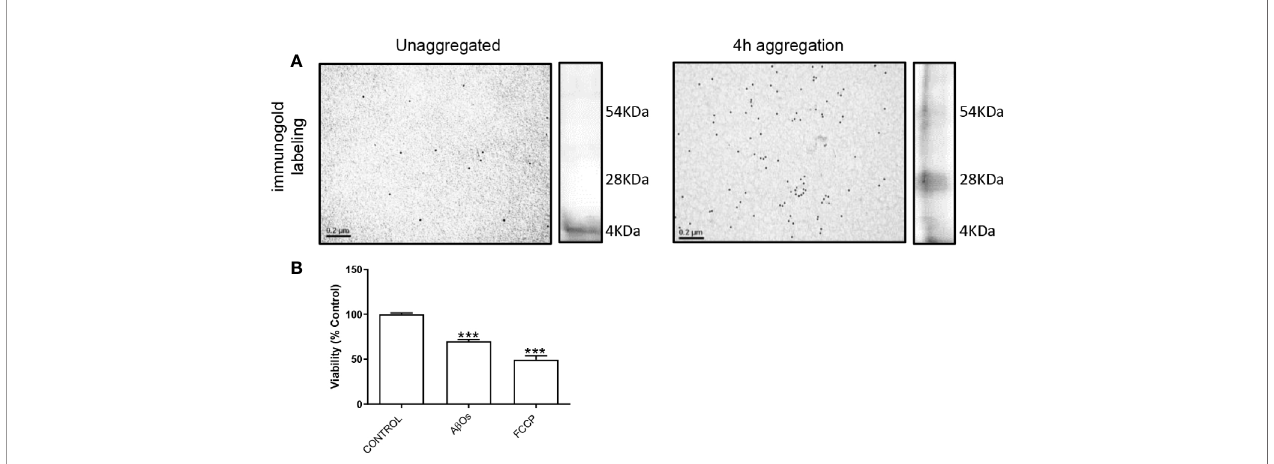
FIGURE 1 | Characterization of A b Os. (A) Microscopy electronic of A b 1 – 40 peptide. A b 1 – 40 peptide was aggregated 4 h and was exposure to colloidal gold particles (10 nm) conjugated with a b amyloid Antibody (MOAB-2). A b 1 – 40 peptide aggregation is visualized by silver staining to the right side of each panel. (B) PC-12 cells were incubated with A b Os 0.5 µM for 24 h and FCCP (10 µM). Data are represented as mean ± SEM. ***p < 0.001 compared between the control group. One-way ANOVA used for all statistical analyses. FCCP, Carbonyl cyanide-4-tri fl uoromethoxy) phenylhydrazone. (n=3 – 5 for each